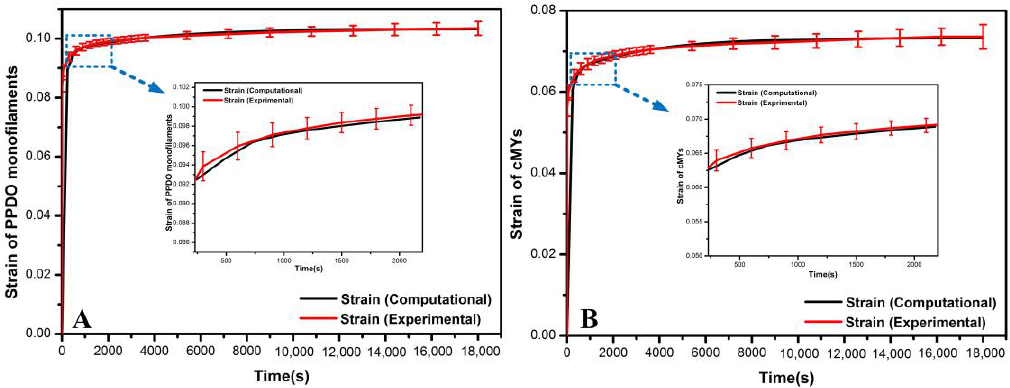
Figure 2. Comparison between the tensile creep tests obtained experimentally and the Abaqus predictions: ( A ) PPDO monofilaments; ( B )